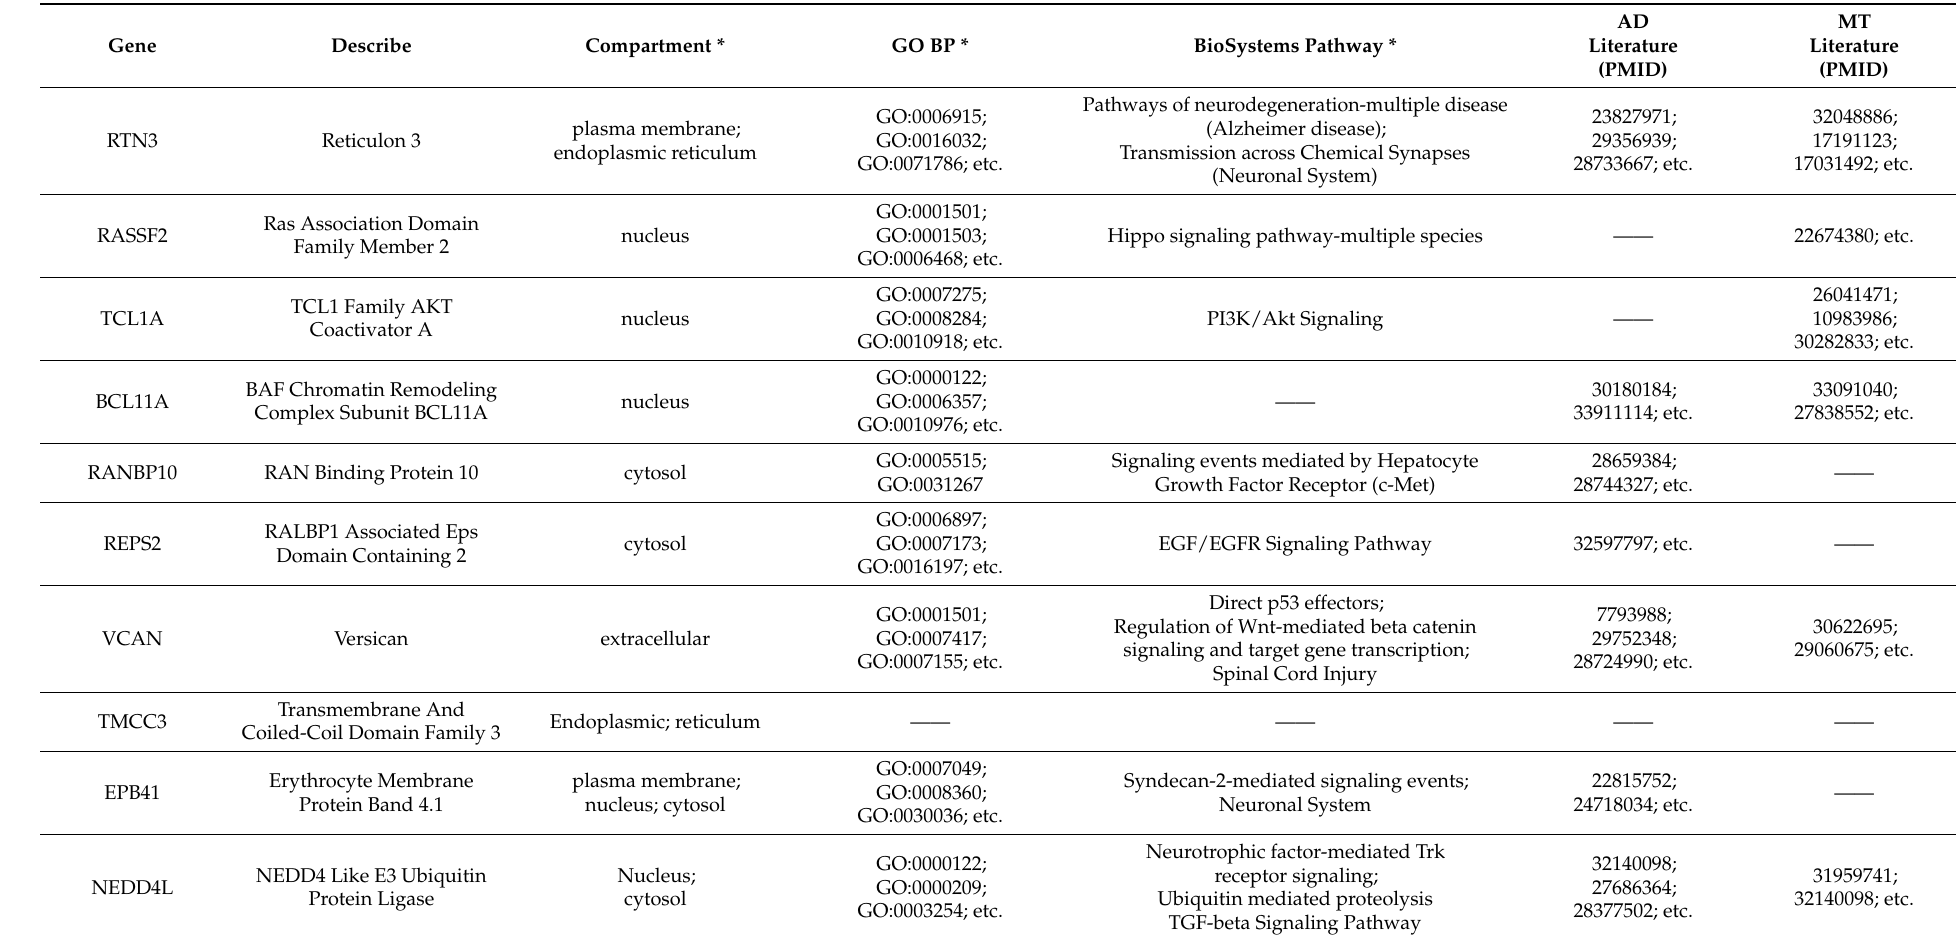
Table 2. Summary information of top 10 critical